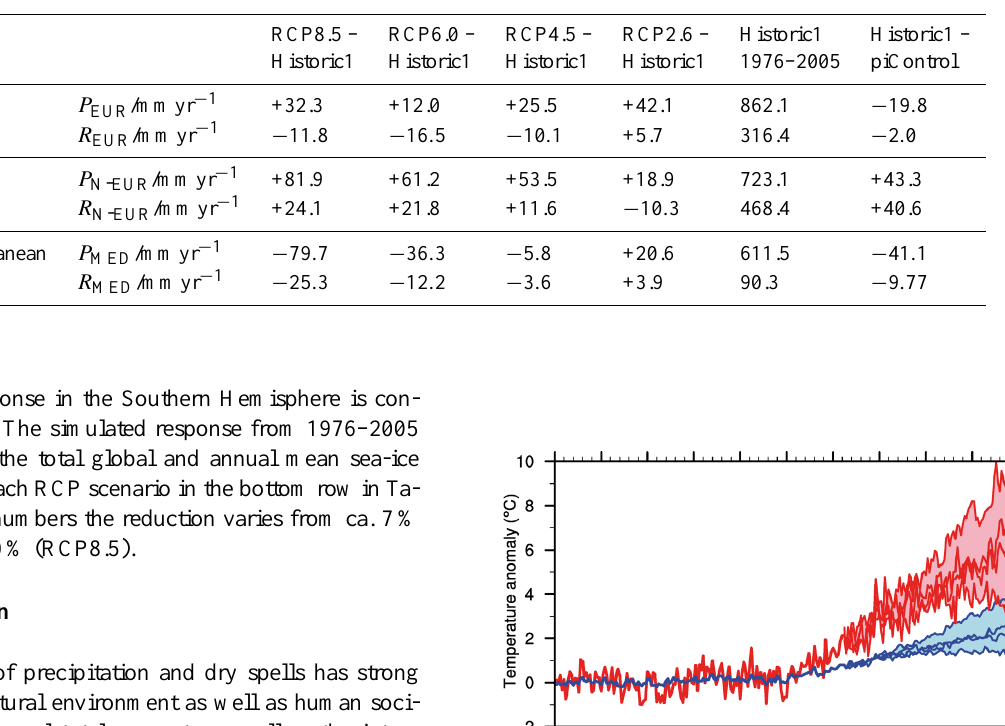
Table 6. Simulated changes in annual total precipitation ( P , mmyr − 1 ) and annual total runoff ( R , mmyr − 1 ) with NorESM1-M in Europe, Northern Europe, and the Mediterranean region, from the period 1976–2005 (Historic1) to 2071–2100 based on the four projected repre- sentative concentration pathways (RCP) scenarios. The rightmost columns contain total values simulated for 1976–2005 (Historic1), and the difference between this and piControl.